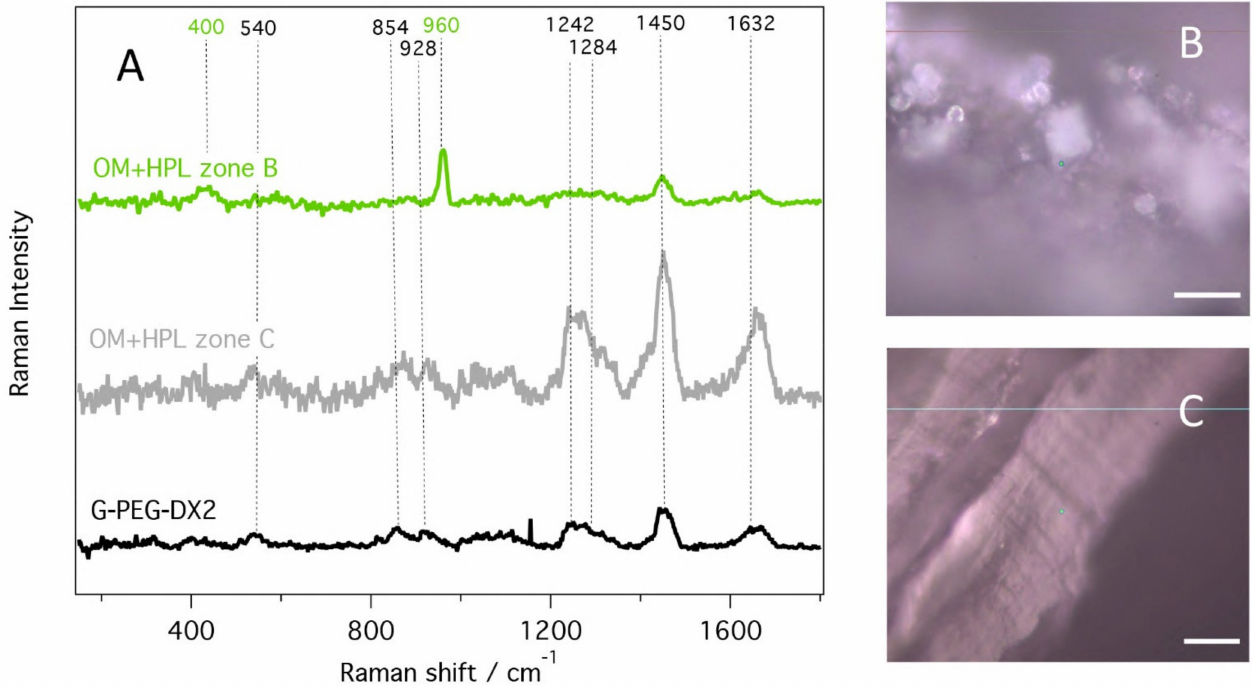
Figure 7. Raman spectra of mineralized hybrid hydrogel. ( A ) Raman spectra acquired on round features of sample G-PEG-Dx2, OM+hPL acquired on spherical particles shown in B (green line) and on the inner area shown in ( C ) (gray line); Raman spectrum acquired on and of the scaffold G-PEG-Dx2 (black line). ( B ) Optical image of OM-hPL sample, showing micrometer sized spherical particles; ( C ) optical image of OM-hPL sample, acquired in a region of the scaffold with no visible mineralization. Scaffold bar: 20 µ